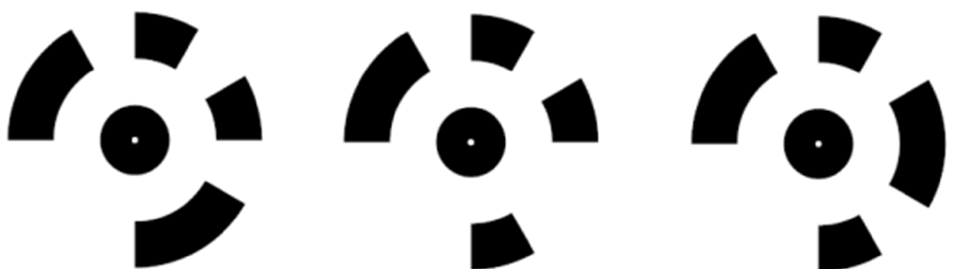
Figure 2. Examples of discs used during the tests.